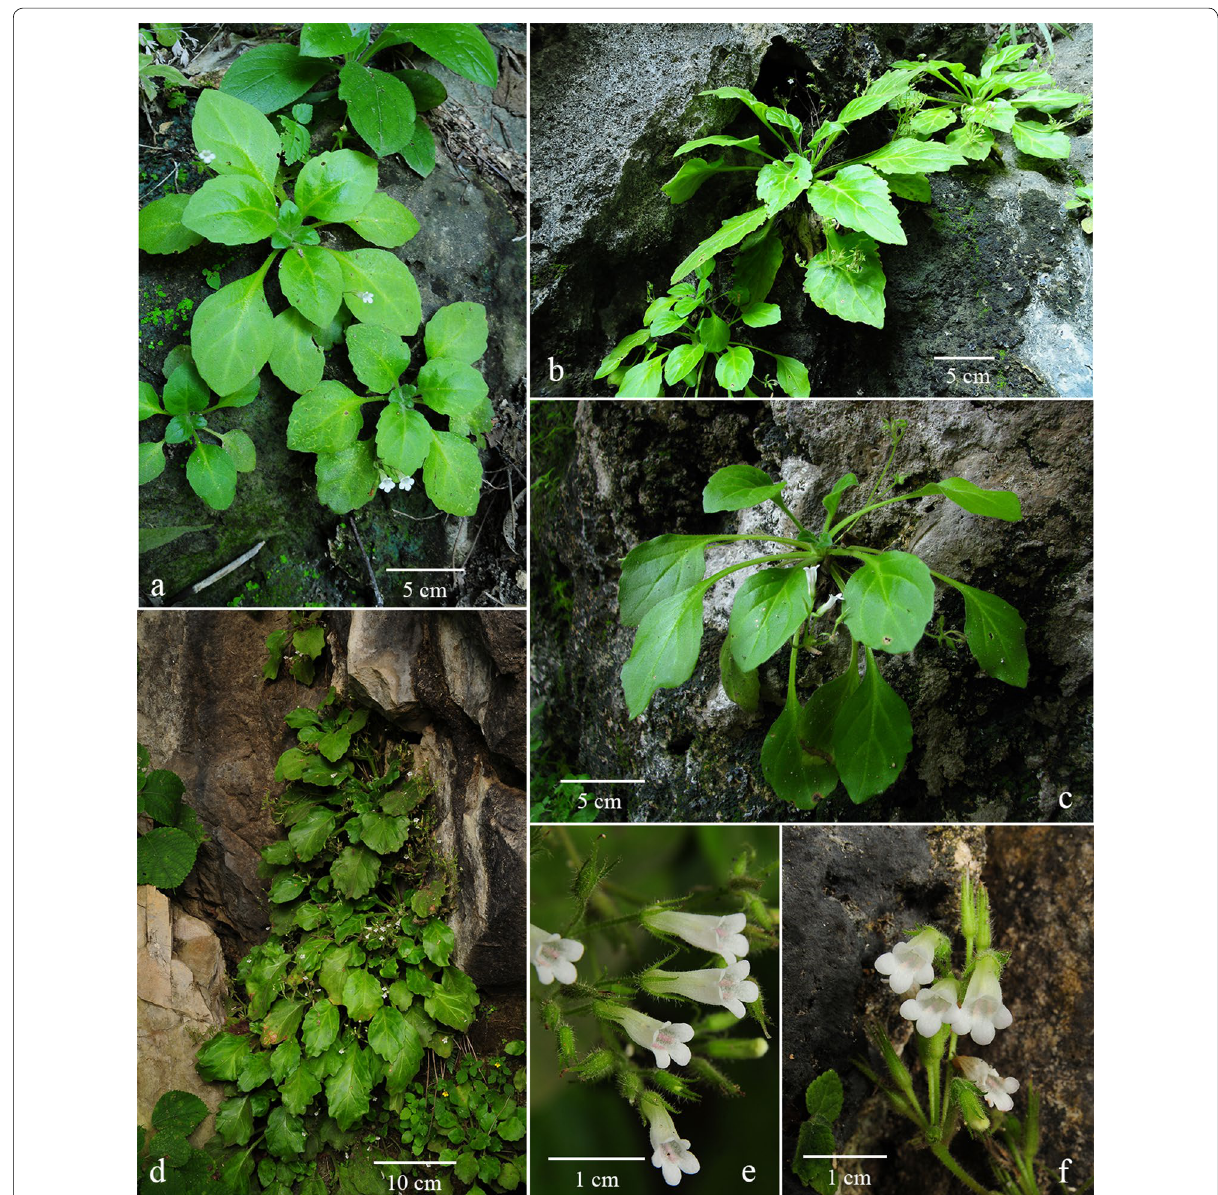
Fig. 10 Primulina subulata var. guilinensis (W.T.Wang) W.B.Xu & K.F.Chung. a – c habit from Guilin; d habit from Hezhou ( K. ‑ F. Chung 1845 ); e flowers (side view); f flowers (face view). a – c from type locality of Chiritopsis repanda var. guilinensis ( K. ‑ F. Chung 1806